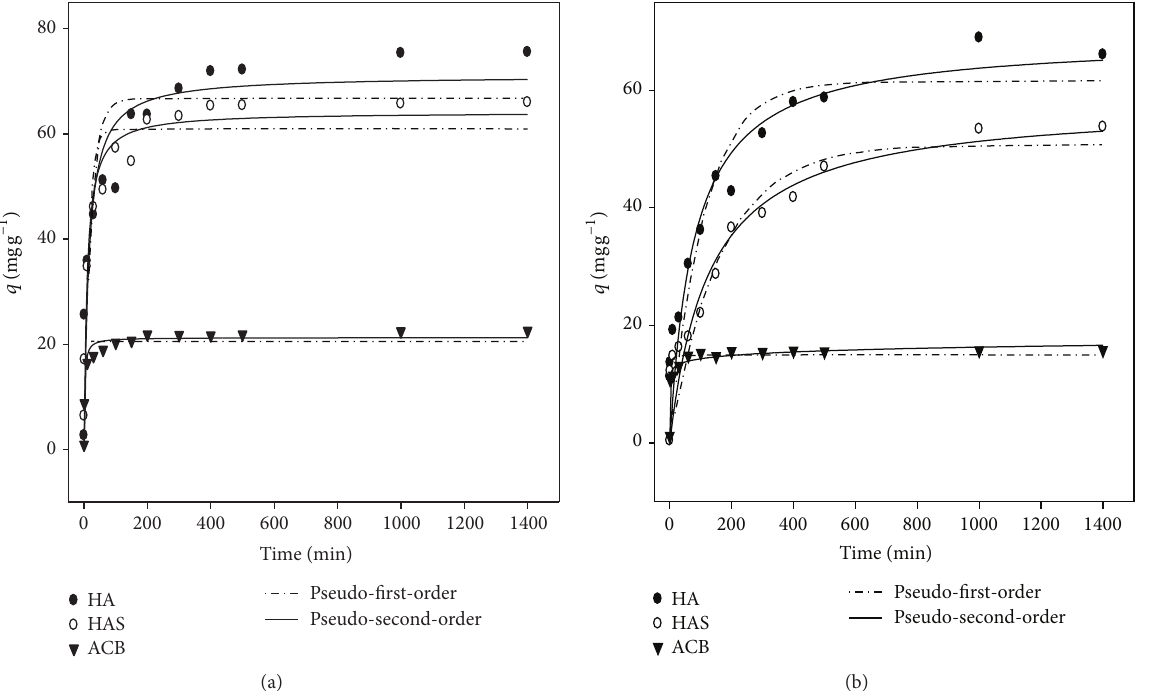
found values as 𝑞 exp = 28 mg g −1 . A study with BSA on asset siriguela charcoal found values as 𝑞 𝑒, exp = 29.35 to 58.26 mg g −1 ; ℎ = 28.74/min to pH = 7.0; and